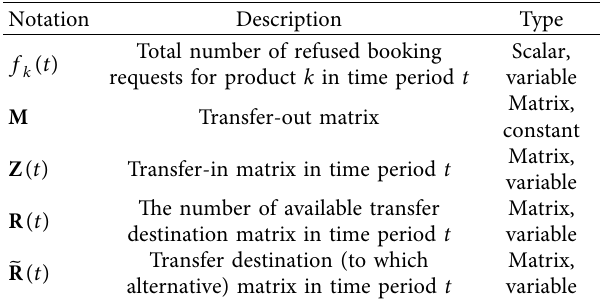
Table 4: Notations used in this